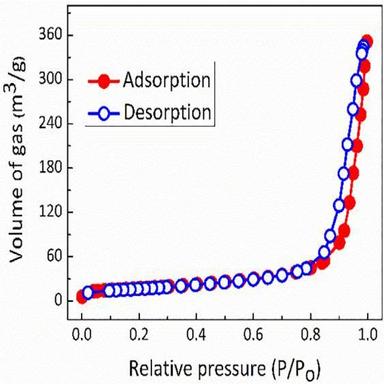
N2 Adsorption and desorption isotherms of Zn0.1Co2.9O4 sample.